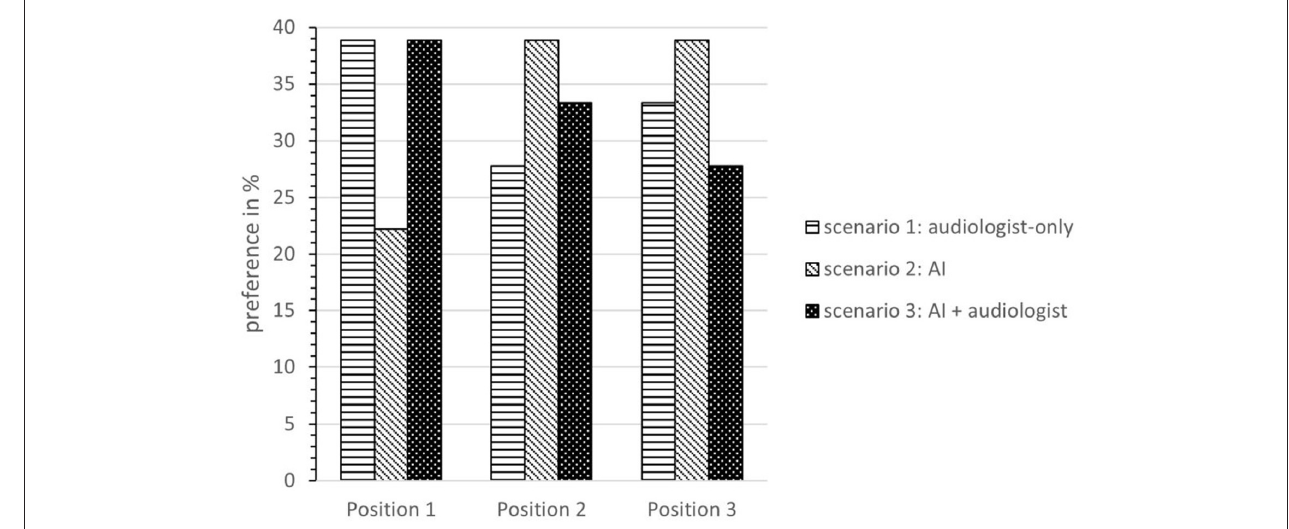
FIGURE 15 | Preference ranking of the three fitting